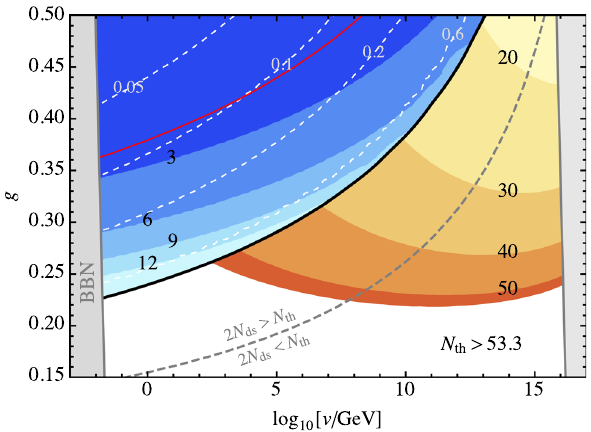
Fig. 2 The duration of the thermal inflation stage is shown by the color coding with the labels indicating the number of e -folds. Above the solid black curve the thermal inflation ends by thermal bubble nucleation, and the white dashed contours indicate the average bubble radius at percolation, H R ∗ . Below the red curve g 2 > λ/ 4. The gray region on the left is excluded by the BBN the reheating temperature and in the gray region on the right the symmetry breaking phase transition is never